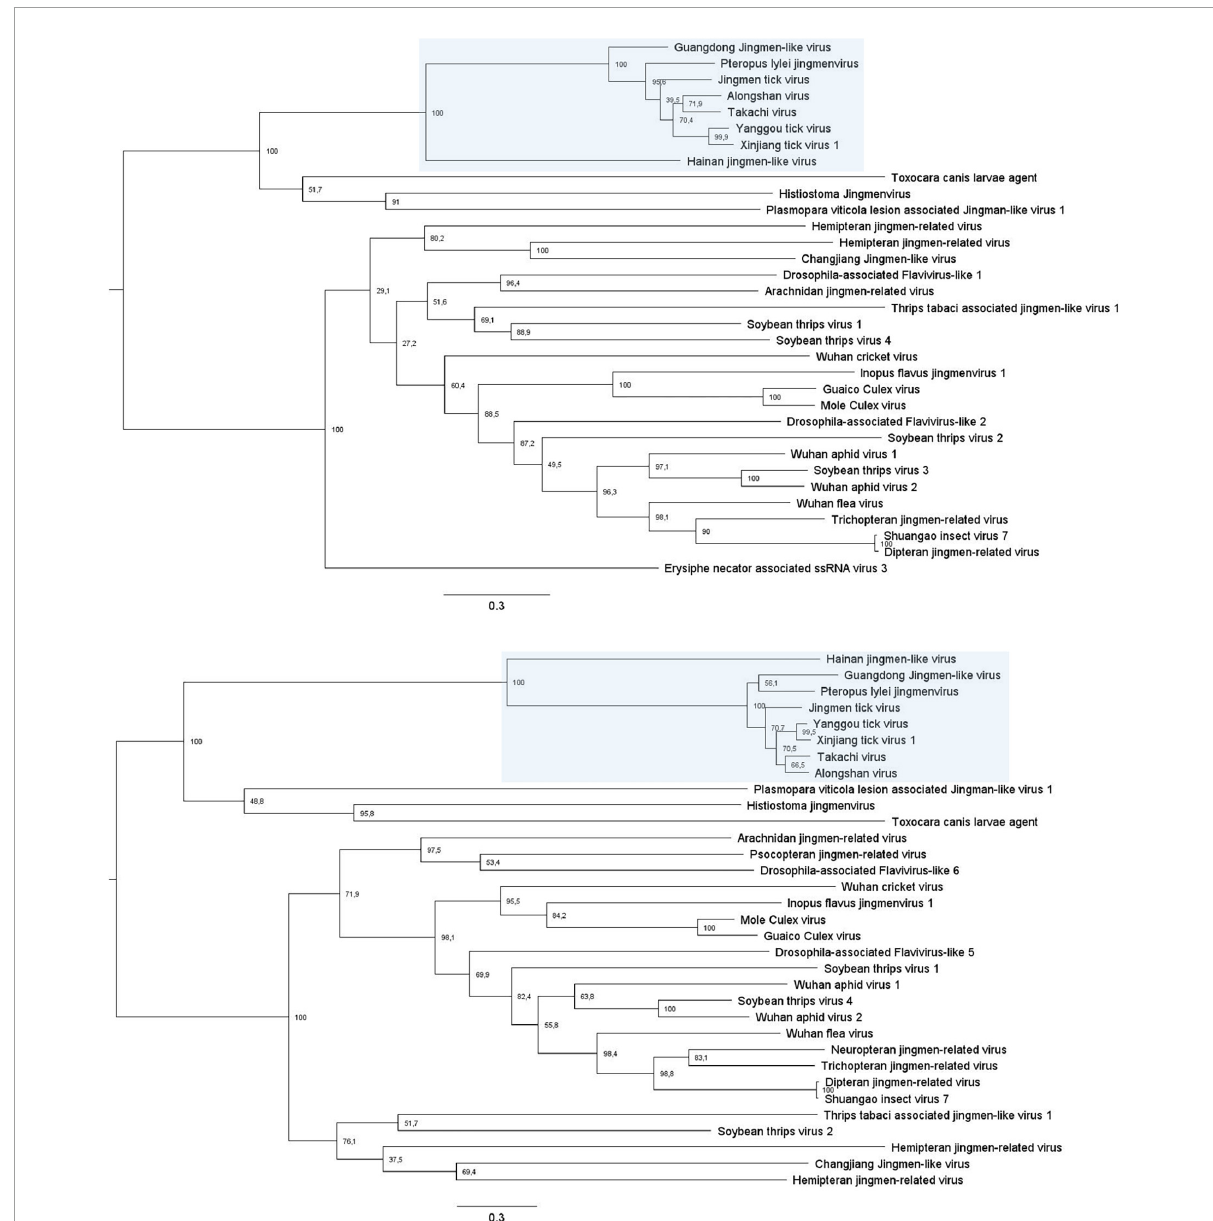
FIGURE5 Phylogenetic analysis of all known jingmenvirus species with full-length NSP1 (Top) and NSP2 (Bottom) ORF amino acid sequences. These trees were built with PhyML with an LG substitution model and midpoint rooted. The branches are labeled with the bootstrap proportion in percentages (out of 1000 bootstraps) and the bars represent 0.3 substitutions per nucleotide position. Jingmenviruses cluster in two main clades, on the one hand the tick- and vertebrate-associated jingmenviruses (shaded in blue) and on the other hand, insect-associated